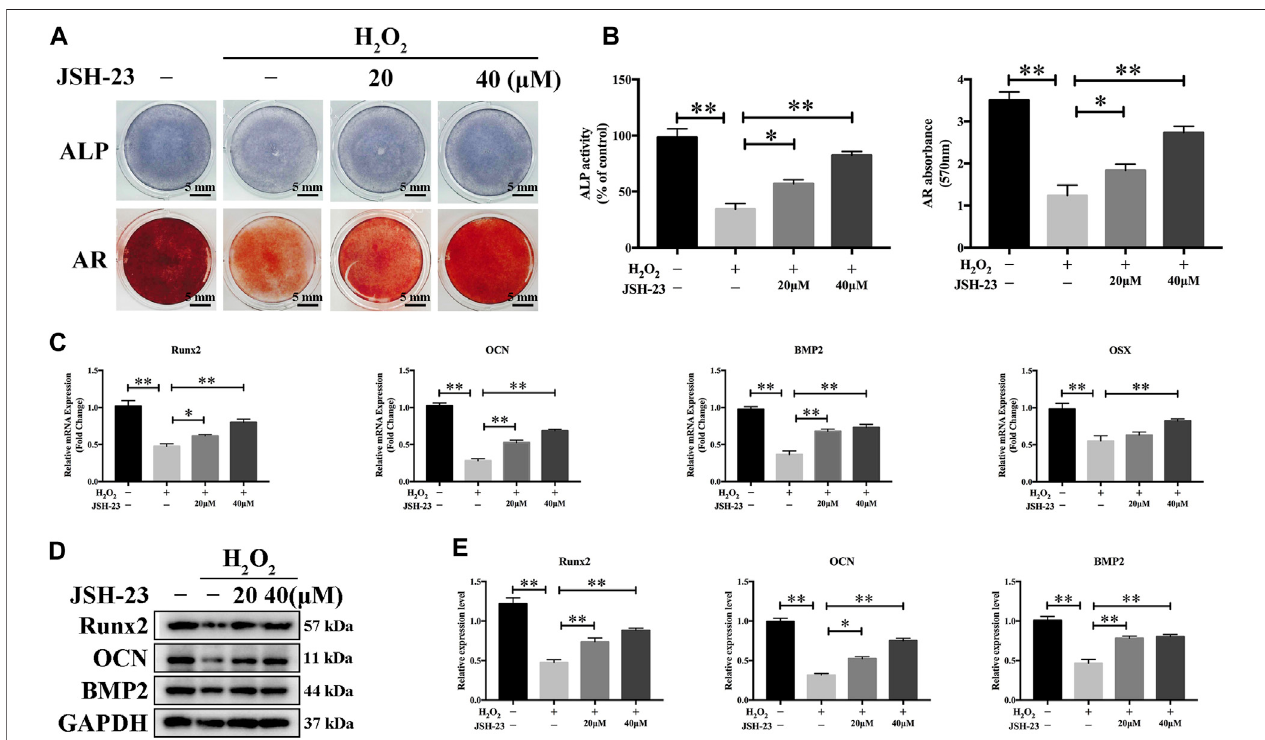
FIGURE 6 | JSH-23 alleviates H 2 O 2 -induced inhibition of osteoblast differentiation in MC3T3-E1 cells. (A) Cells were pretreated with JSH-23 for 24 h before induction of differentiation until day 7 or 21 and then exposed to H 2 O 2 (400 μ M) for 4 h. ALP or AR staining was performed. (B) Quantitative analysis of ALP activity and AR staining in cells based on absorbance. (C) The expression of the osteoblast-speci fi c genes (Runx2, OCN, BMP2 and OSX) was analyzed by qPCR. (D) The protein expression levels of Runx2, OCN and BMP2 were measured using western blotting. (E) Quantitative analysis of the western blotting results. The values are shown as the means ± SDs, n (cid:1) 3; * p < 0.05, ** p <